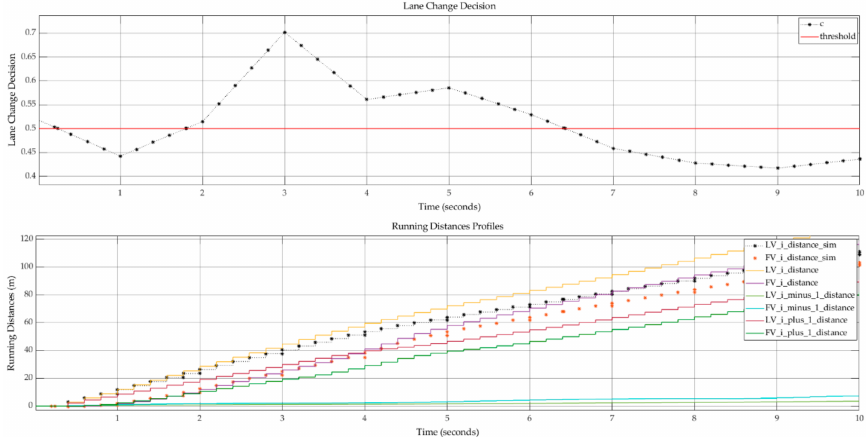
Figure 12. LV and FV–running distances profiles.